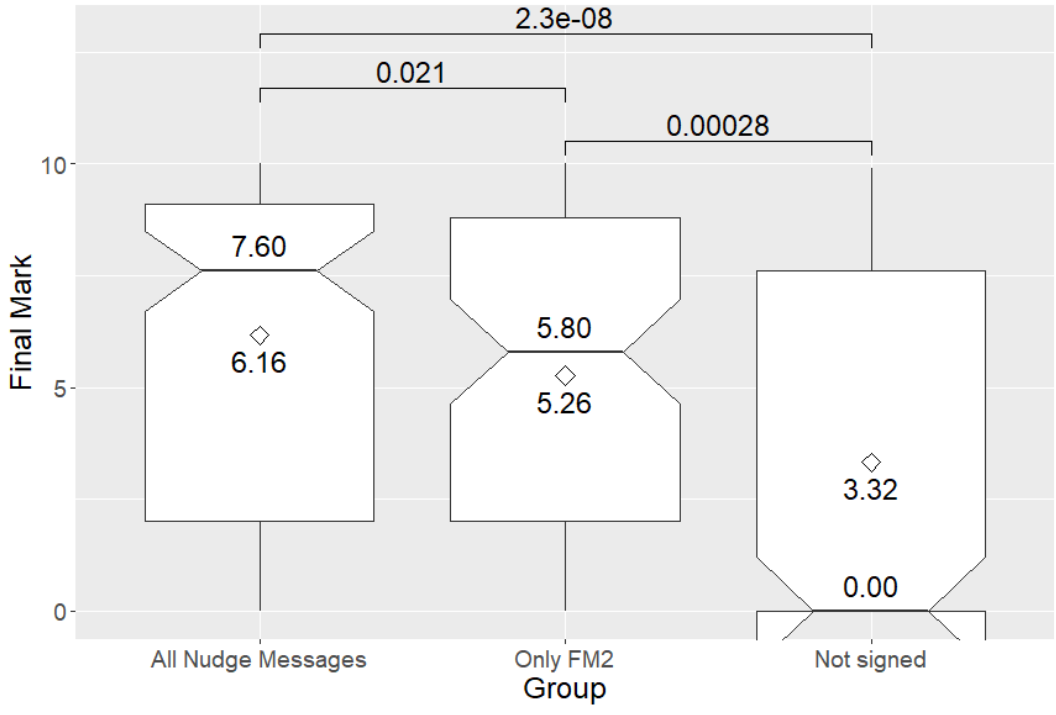
Two-Sample Wilcoxon Test